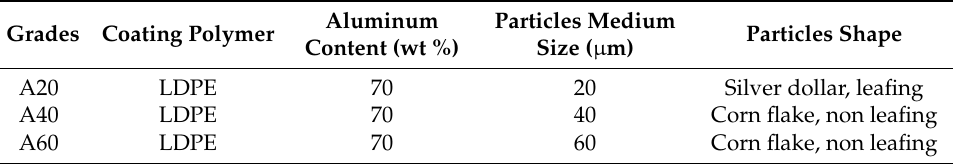
Table 1. Grades used in this study. LDPE: low density